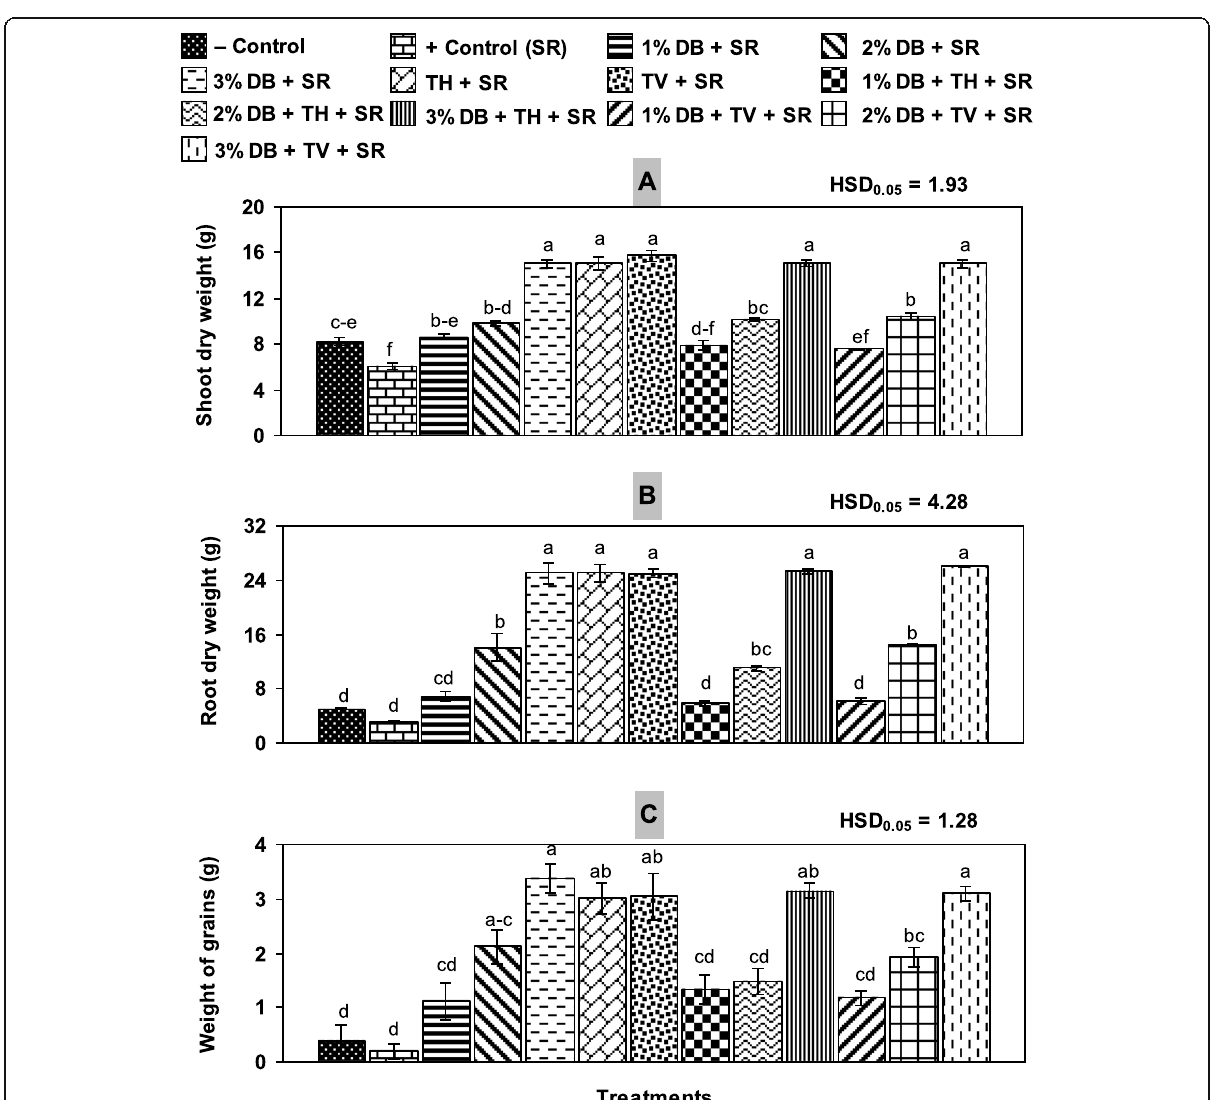
Fig. 1 Effect of Sclerotium rolfsii (SR), Trichoderma harzianum (TH), T. viride (TV), and dry biomass (DB) of Chenopodium album on growth and yield of chickpea var. Noor 2009. Vertical bars show standard errors of means of five replicates. Values with different letters at their top show significant difference ( p ≤ 0.05) as determined by Tukey ’ s HSD